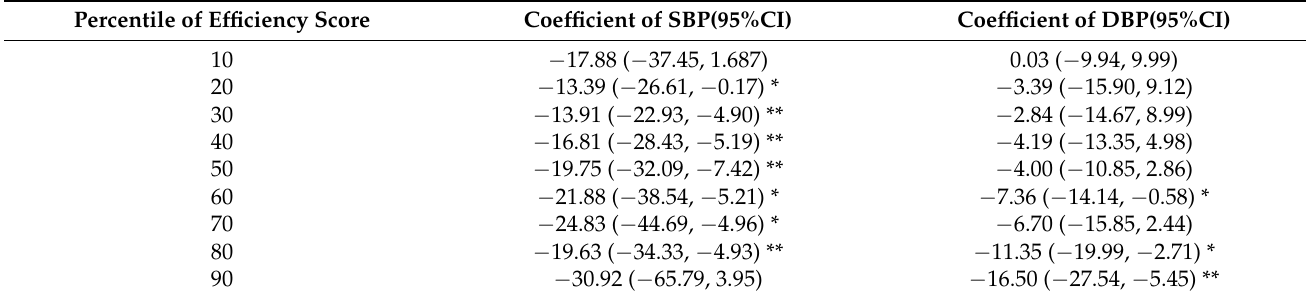
Table 3. Quantile regression between the efficiency score with systolic and diastolic blood